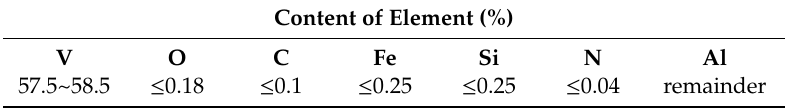
Figure 7. The composition of the product with di ff erent heating time ( a ): distribution of impurities in the sample; ( b ): V content in the sample. Table 3. The composition of the AlV55 alloy for commercial application (TS / T 579-2014). Content of Element